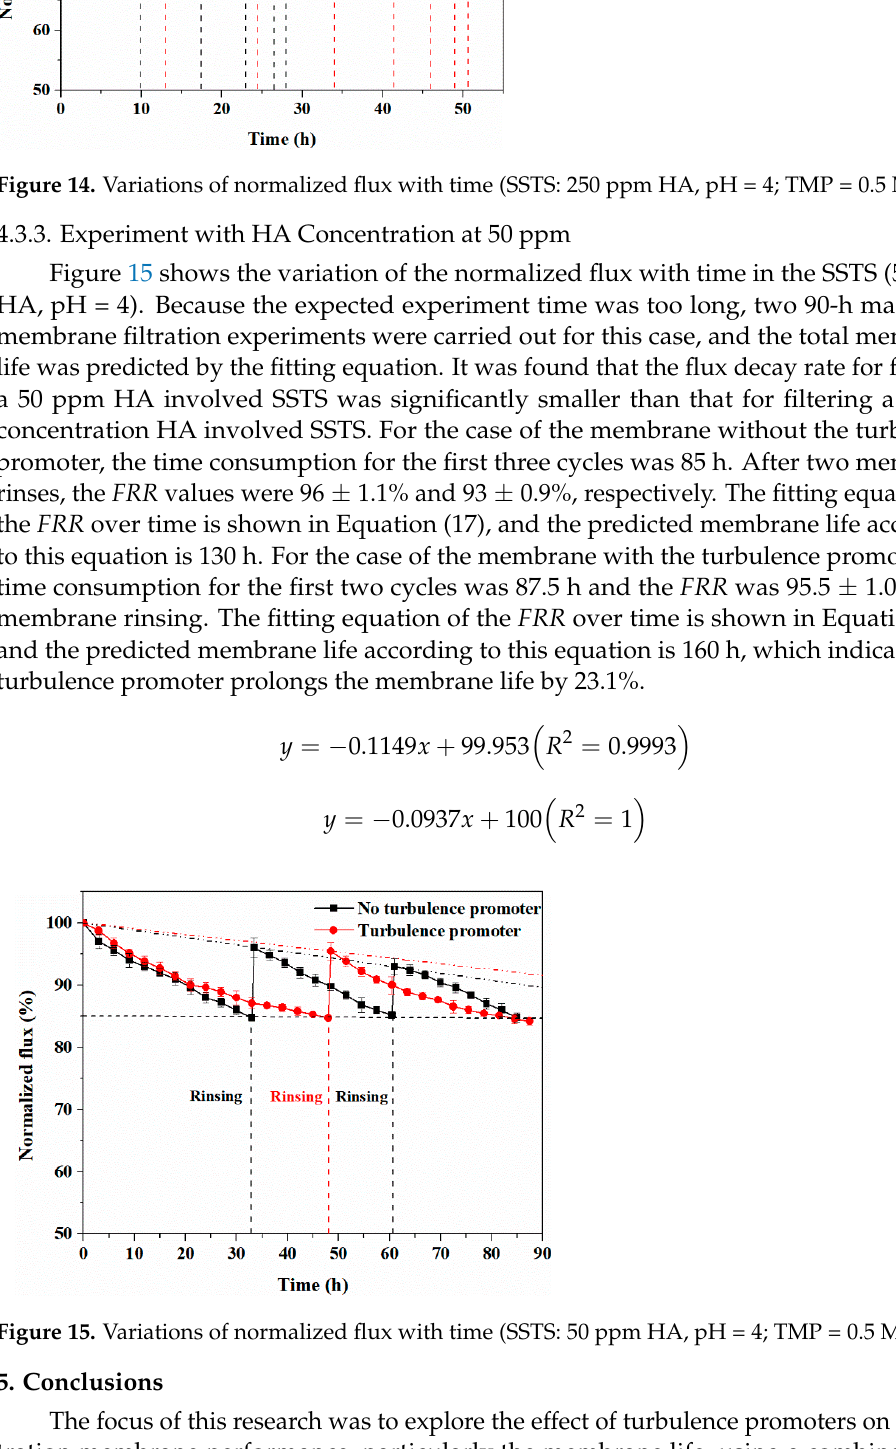
Figure 14. Variations of normalized flux with time (SSTS: 250 ppm HA, pH = 4; TMP = 0.5 MPa).